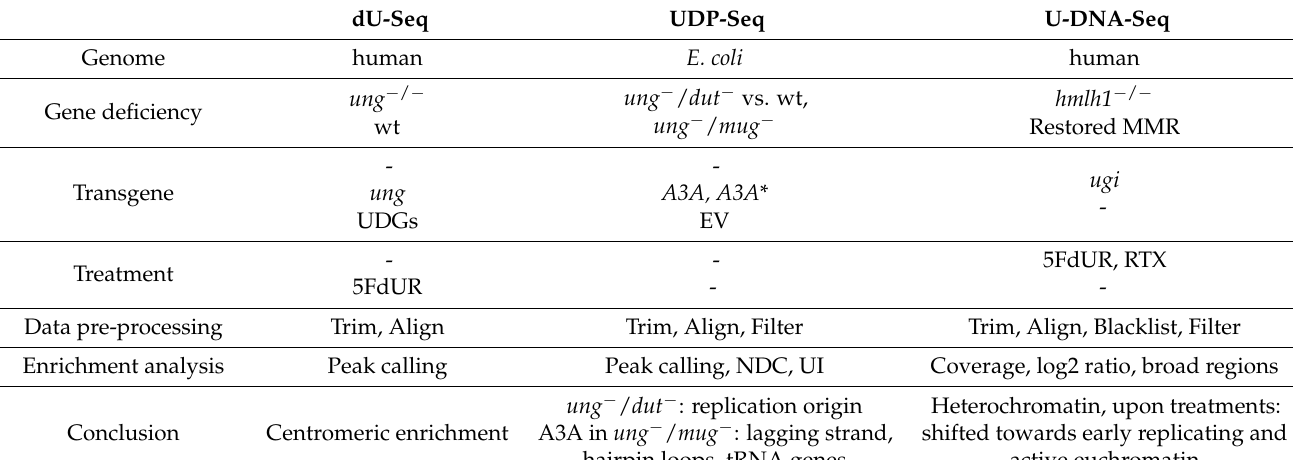
Table 1. Summary of studies based on dU-seq, UDP-seq and U-DNA-Seq. Abbreviations are as follows: ung , dut , mug , and hmlh1 are genes encoding UNG, dUTPase, double stranded U-DNA specific UDG of E. coli , and human MLH1, respectively. MMR: mismatch repair, A3A and A3A*: APOBEC3A and its inactive mutant, EV: empty vector, NDC: normalized differential coverage, UI: uracilation